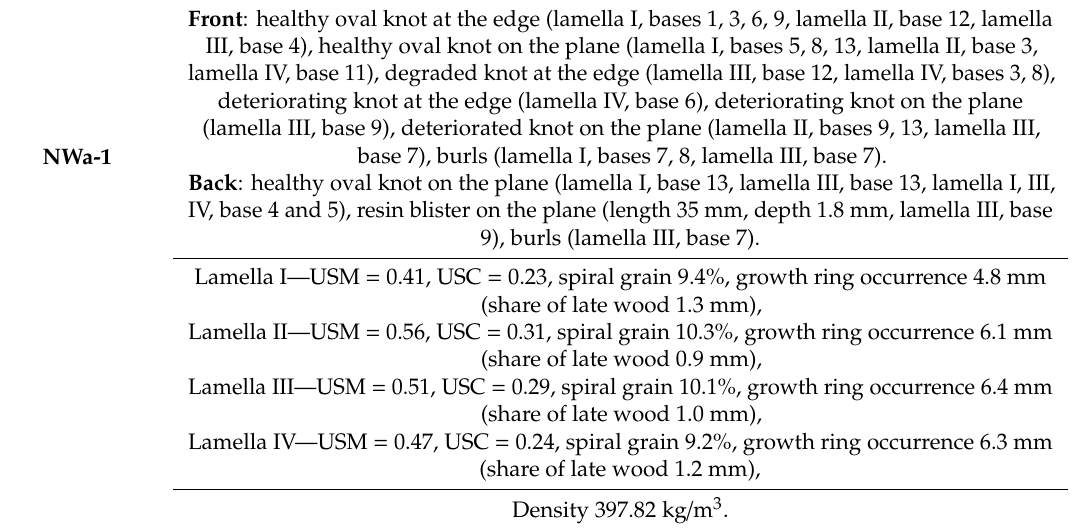
Front : healthy oval knot at the edge (lamella III, base 7, lamella IV, bases 1, 3, 6), deteriorating oval knot at the edge (lamella III, base 2), deteriorated oval knot on the plane (lamella II, base 4), deteriorated knot at the edge (lamella I, base 7), healthy oval knot on the plane (lamella II, base 8), deteriorating oval knot on the plane (lamella I, base 11, lamella III, base 10, lamella IV, base 11), healthy oval knot on the plane (lamella II, base 13), longitudinal knot on the plane (lamella IV, base 13), burls (lamella IV, base 8). Back : healthy oval knot on the plane (lamella I, bases 7, 9, lamella II, bases 8, 9, lamella III, bases 7, 13, lamella IV, bases 1, 3), deteriorating oval knot at the edge (lamella I, bases 1, 4, lamella IV, bases 8, 9), healthy oval knot at the edge (lamella I, base 5, lamella III, bases 2, 5), deteriorated oval knot at the edge (lamella II, base 6, lamella III, base 3, lamella IV, base 13), deteriorating oval knot on the plane (lamella I, base 5, lamella IV, base 13), resin blister on the plane (length 33 mm, depth 1.8 mm, lamella II, base 10, lamella IV, base 12), burls (lamella III, bases 7, 8, lamella IV, base 8).